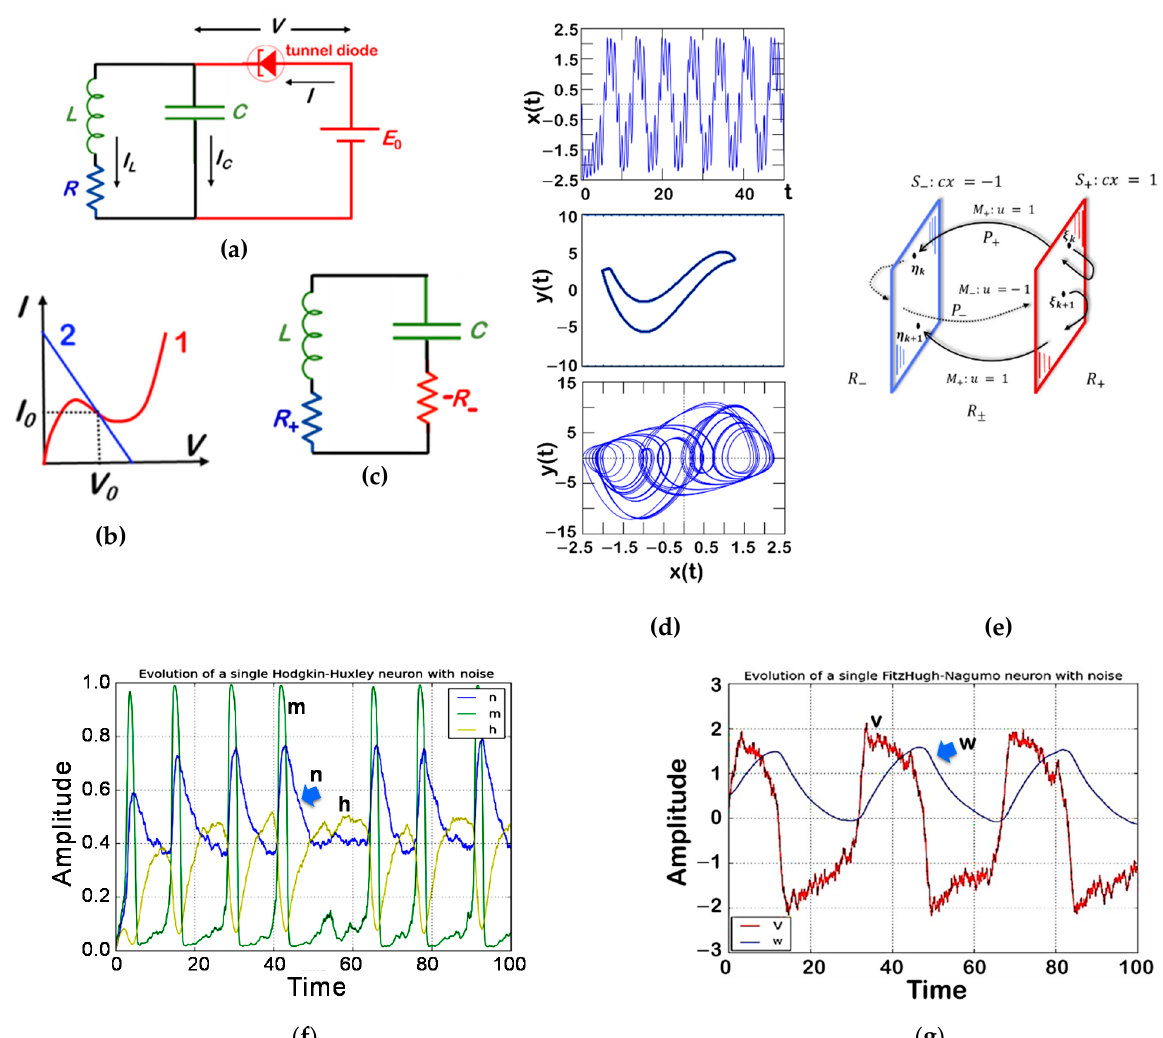
Figure 2. Van der Pol oscillator; ( a ) electrical circuit of a van der Pol oscillator with a tunnel diode showing negative resistance; ( b ) I vs V characteristic I = f ( V ) of the tunnel diode (curve 1) and load line I = ( E 0 – V ) / R for a constant current (line 2). These two lines intersect at the operation point V = V 0 , I = I 0 ; ( c ) equivalent circuit of the tunnel-diode oscillator for alternating current with a negative resistor –R - (adapted from [63]); ( d ) the x vs time series of Equations (2) and (3), Poincar é map, and phase portrait (projection of the extended 3D portrait) for values A = − 50, ε = 5 and ω = 7, corresponding to almost periodic orbit (obtained in this study using wxMaxima 20.06.6 and the Runge-Kutta method, supplementary information) - Poincar é map adapted from [52]; ( e ) partitioning of the state space and the Poincar é maps [48]; ( f ) noisy Hodgkin-Huxley model; time evolution of the three ion channel variables n, m, and h [64]; ( g ) time evolution of the membrane potential and the adaptation variable in the noisy FitzHugh-Nagumo model (V—voltage, w—current). ( f,g ) adapted from